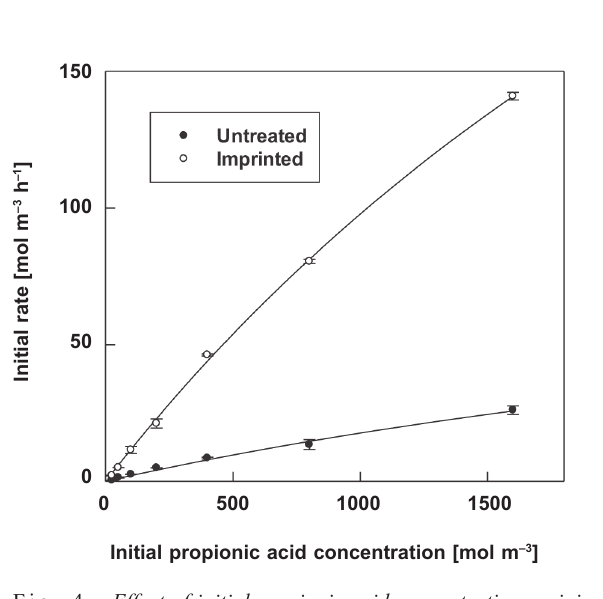
Fig. 4 – Effect of initial propionic acid concentration on ini- tial esterification rate with untreated and imprinted Table 1 – Apparent kinetic parameters of solvent-free esteri- fication Untreated Imprinted